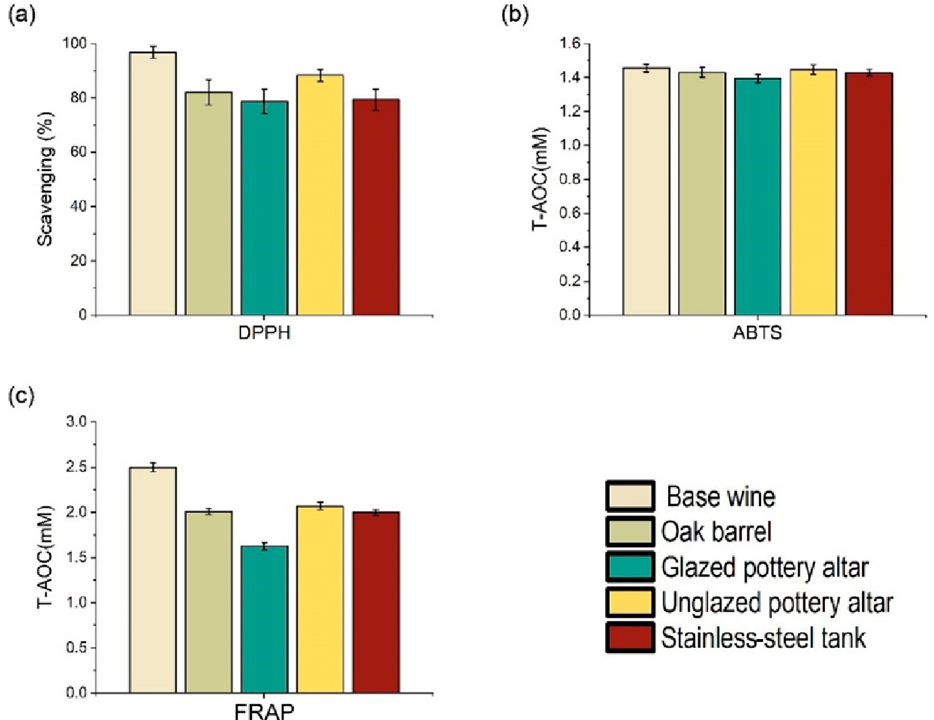
Figure 2. Antioxidant activity test results. ( a ) DPPH scavenging ability of red wine aged in different containers. ( b ) ABTS total antioxidant activity of red wine aged in different containers. ( c ) FRAP scavenging ability of red wine aged in different containers.